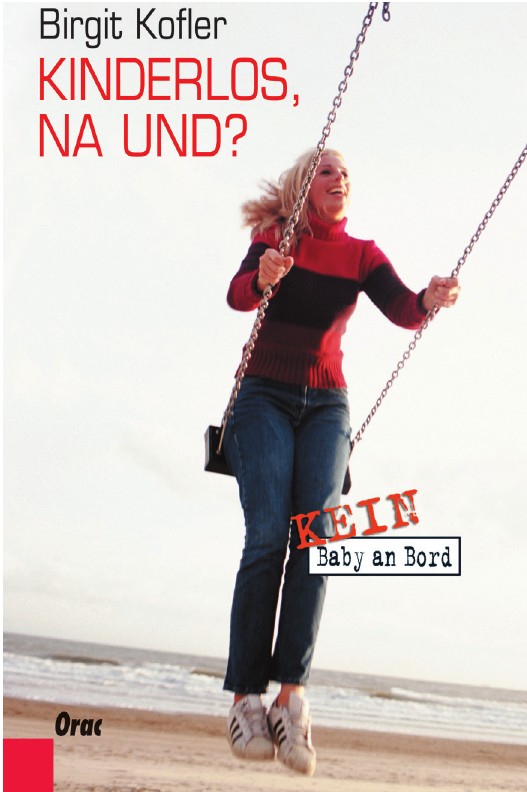
Figure 27. I Don’t Want a Child:13 Stories About an Unpopular Decision (2013). Used by permission of Mabuse-Verlag.